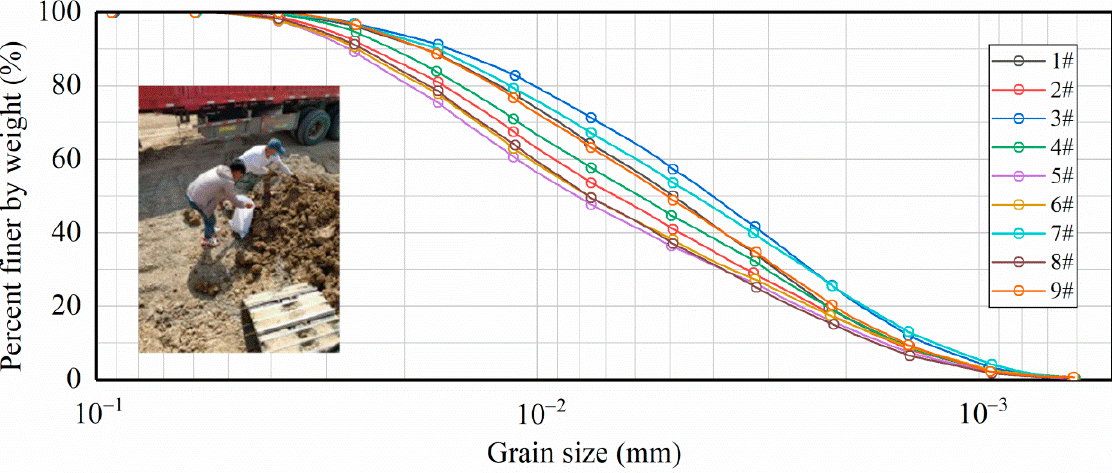
Figure 2. Cumulative distribution curves for particle size gradation of experimental soil. Table 1. Physical and mechanical indexes of experimental soil.